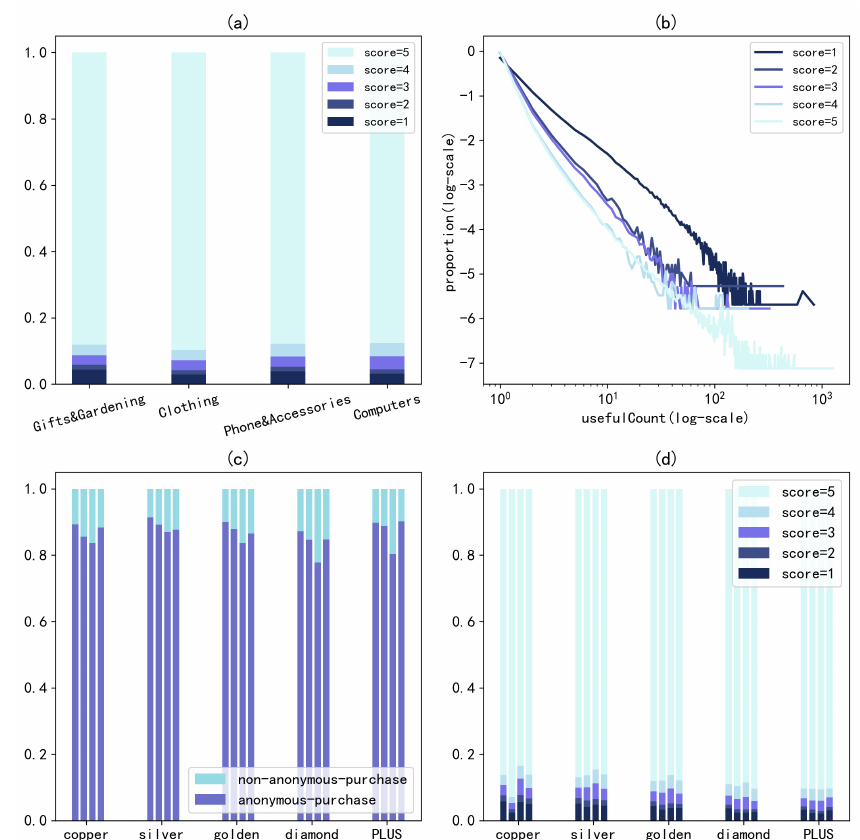
Figure 1. Overview of dataset. ( a ) The stacked histogram of different scores’ proportions for four sectors. ( b ) Log–log distribution of usefulCount for every review, taking the sector Computers as example. ( c ) The stacked histogram of identified buyers for five user levels, distinguishing four sectors. ( d ) The stacked histogram of different scores’ proportions for five user levels, distinguishing four